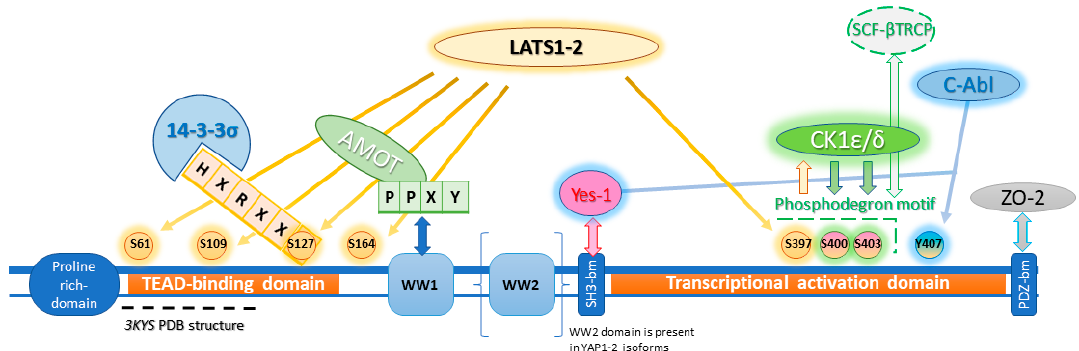
Figure 2. YAP principal interactors and phosphorylation sites. YAP phosphorylation main site is on S127 with consequent 14-3-3 σ proteins recruitment, YAP cytoplasmic sequestration and phosphorylation site shielding from phosphatases. LATS1-2 also promotes phosphorylation on other